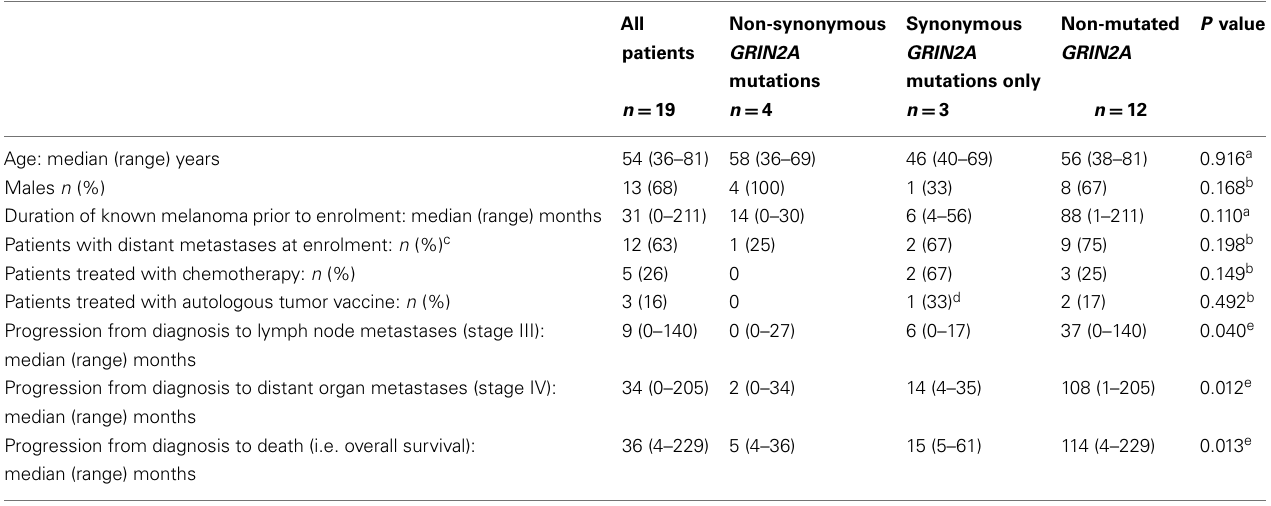
Table 2 | Clinical characteristics for all patients, according to the presence or absence of GRIN2A mutations in tumor-derived cell lines